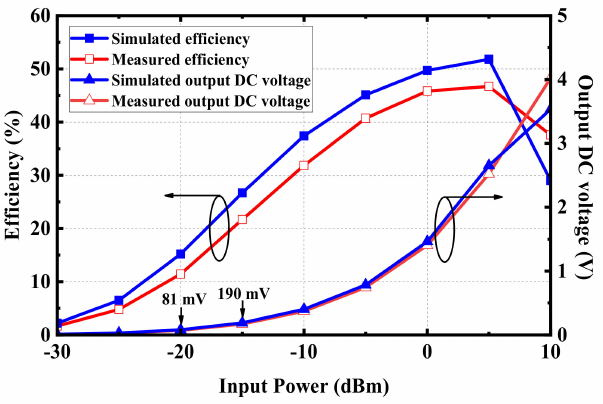
Figure 16. RF-to-DC conversion efficiency and output DC voltage of the